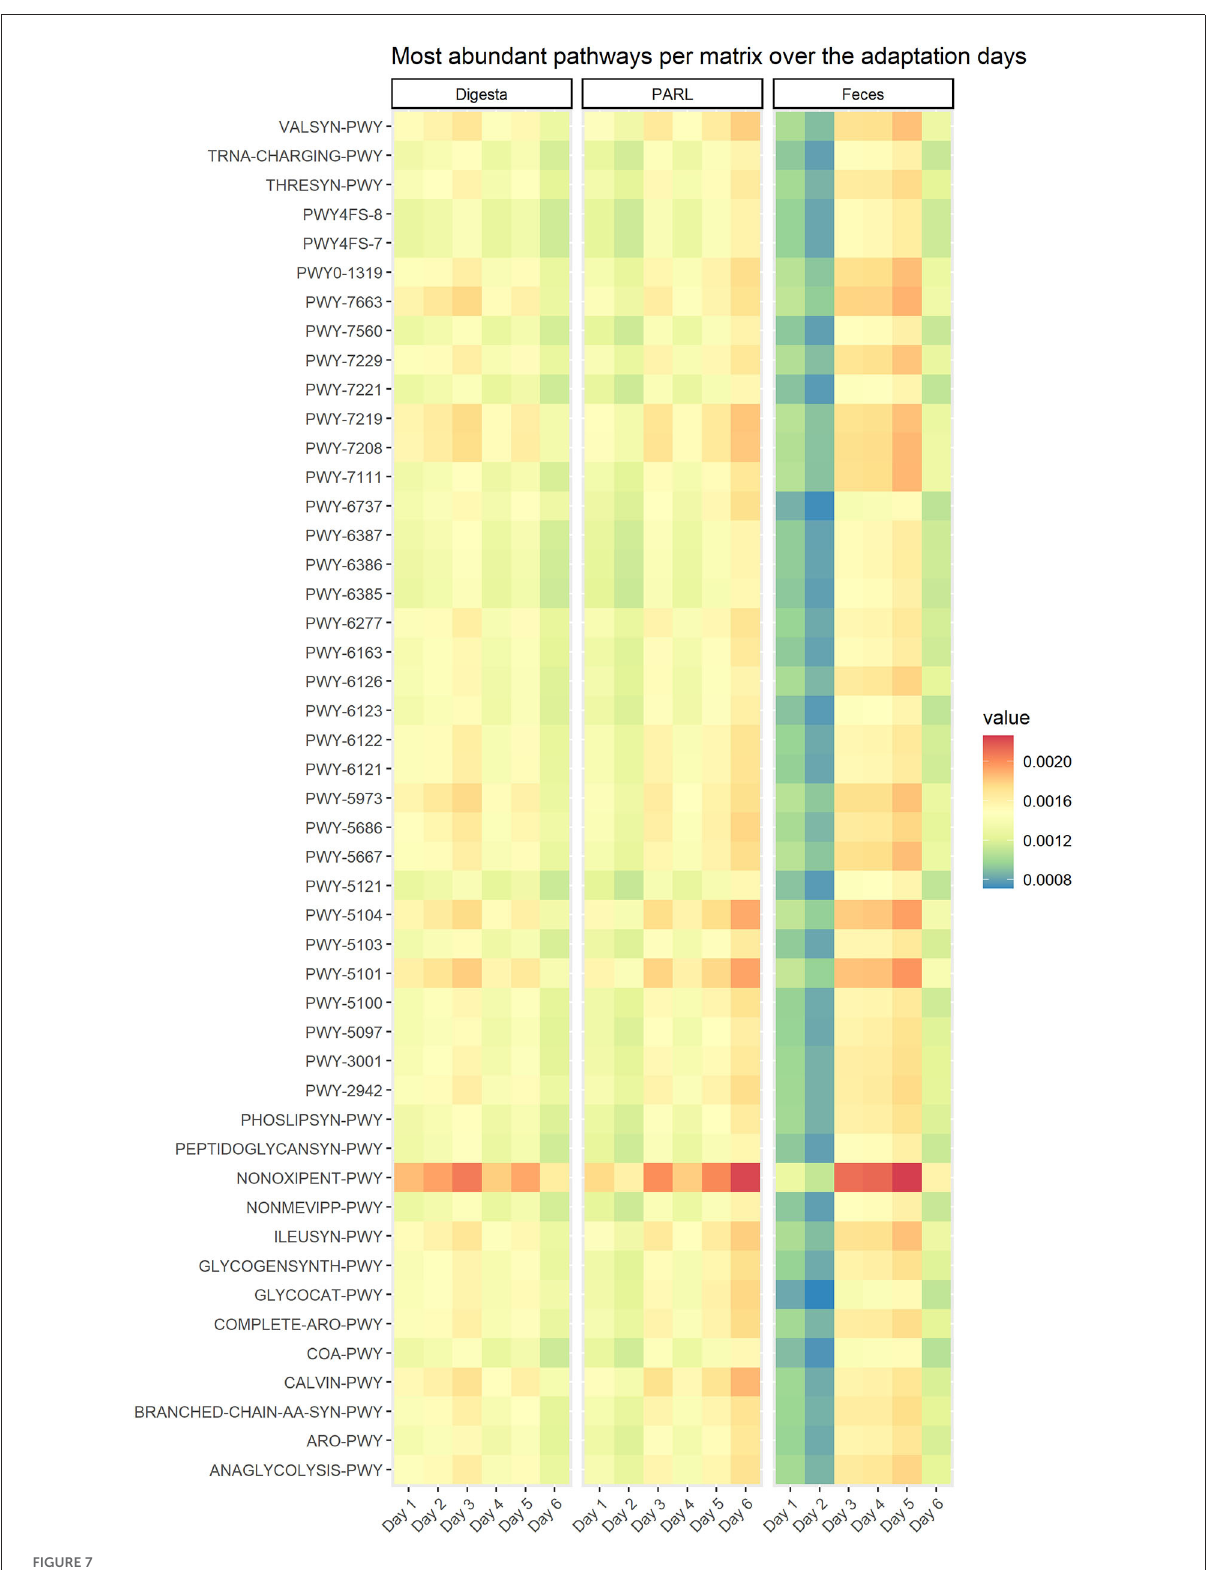
FIGURE7 Relative abundance of the most abundant pathways for the three analyzed matrices. Pathways were predicted via PICRUSt2 based on the 16S rRNA gene amplicon sequencing of samples of solid digesta (Digesta), particle associated rumen liquid (PARL) and